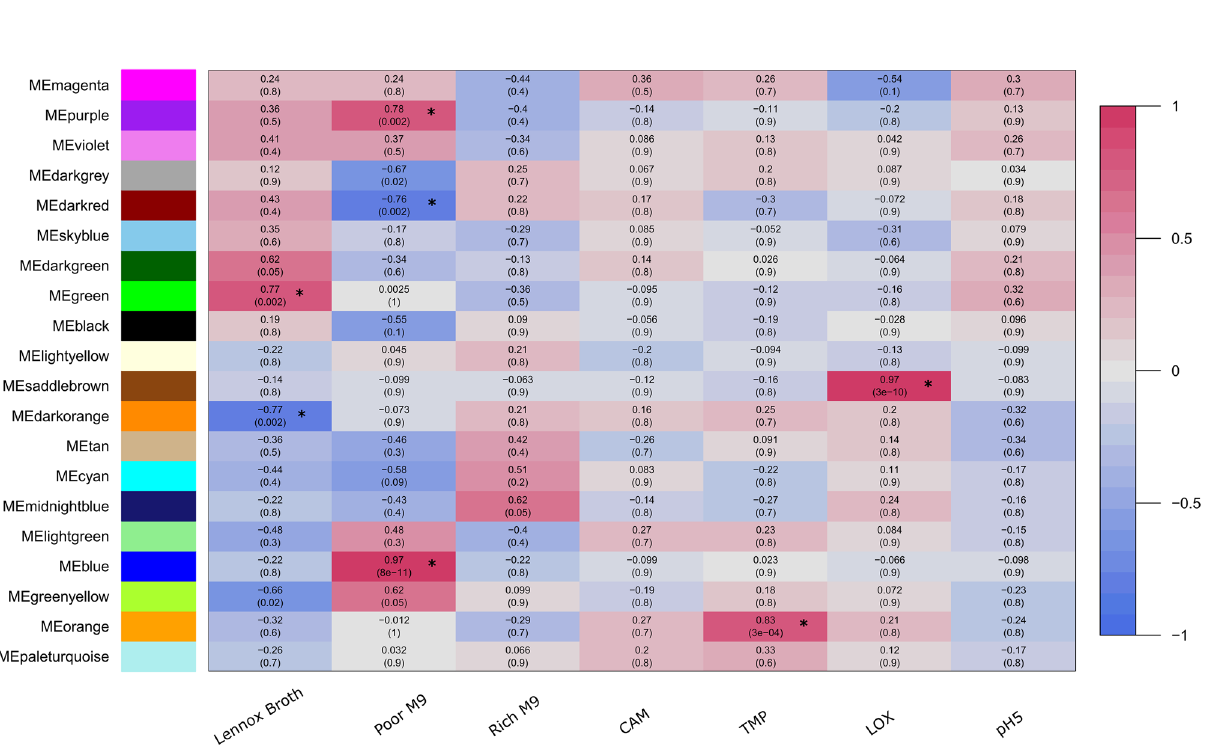
Figure 3. Module-trait relationships. Associations between module eigengenes (ME) and experimental conditions. Rows represent MEs and columns represent growth environments. Numbers outside and within parentheses are correlation coefficients and FDR corrected p-values of the correlations, respectively. Positive correlations are indicated by pink colour and negative correlations by blue colour. Significant associations are highlighted with an asterisk sign